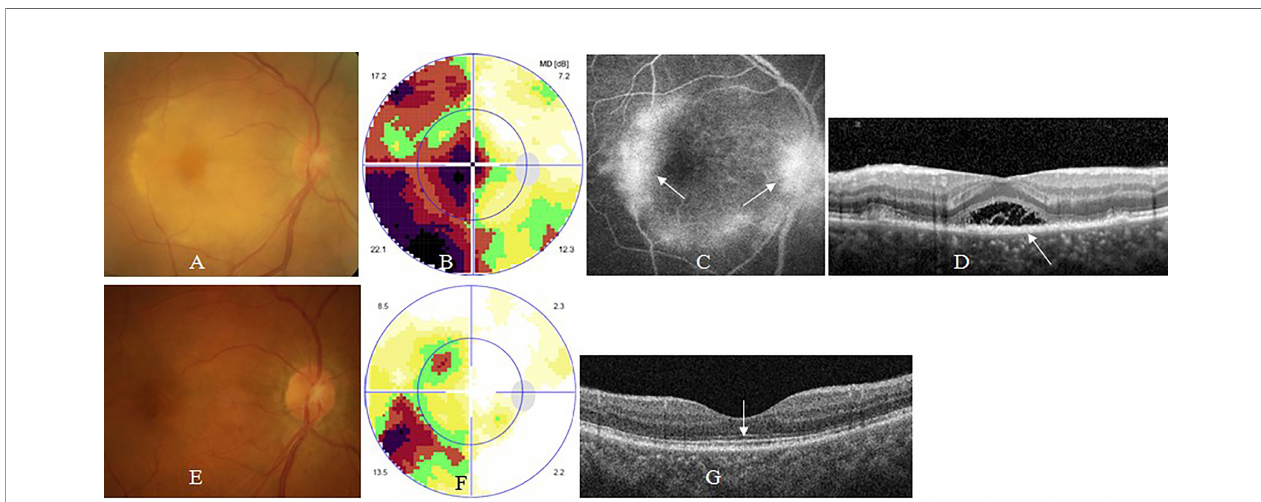
FIGURE 2 | Syphilic placoid chorioretinitis. A 57-year old man complained of sudden visual loss in the right eye for 1 week. At presentation, his right eye had visual acuity of counting fi ngers, clear anterior segment and placoid edema of posterior retina (A) , large central scotoma on visual fi eld test (B) , late-staged hyper fl uorescence of posterior retinal and optic disc on fl uorescein angiography (FFA) ( arrow, C) , disruption or loss of outer segments of macular retina (arrow) and serous macular detachment on optical coherence tomography (OCT) (D) . Two months after antibiotic therapy, his visual acuity recovered to 20/25 in the right eye, with normal posterior retina (E) , small arcuate scotoma on visual fi eld test (F) , and normal contour of outer segments of macular retina on OCT ( arrow, G) .